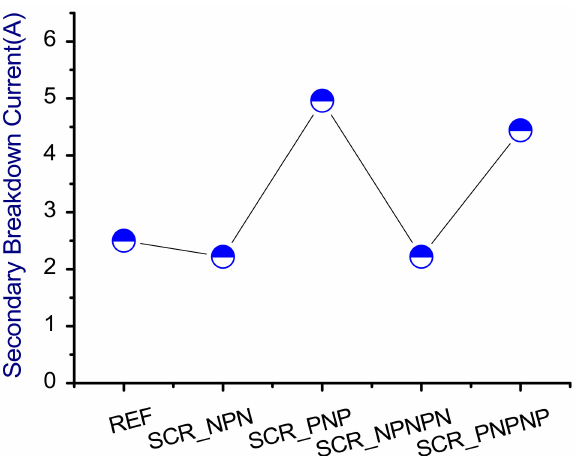
Figure 17. Secondary breakdown-current distribution chart of HV nLDMOSs with embedded SCR